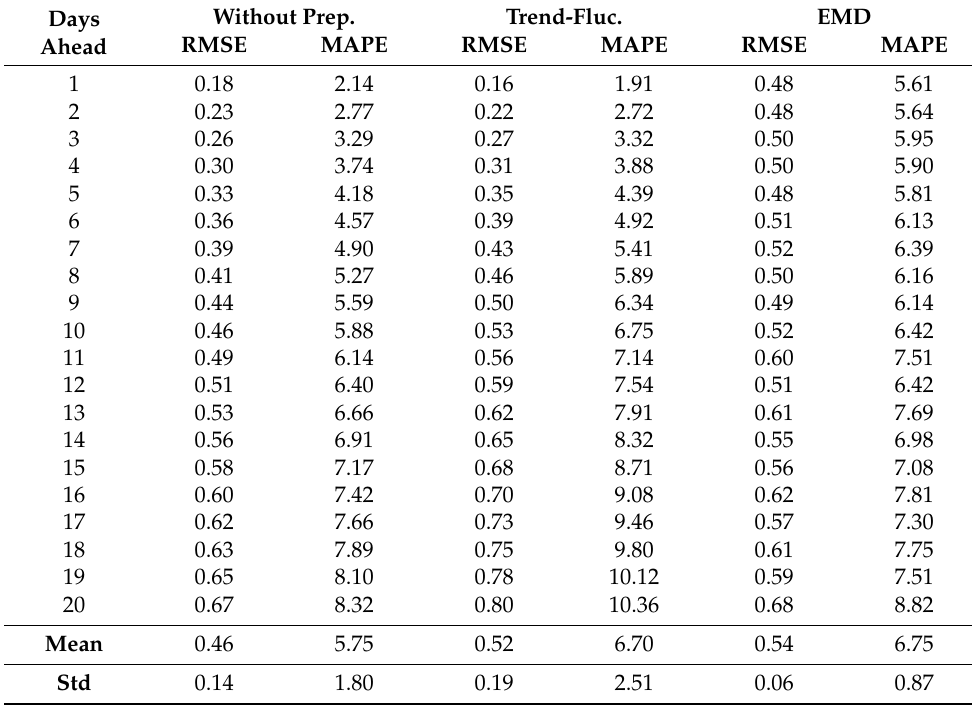
Table 5. Predictions with LSTM for the reduced data set (2009–2016); 60% of them were used for training and 40% for validation. Data have been scaled with standardization for “Without Prep.” and “Trend-Fluc.” and with Min-Max for